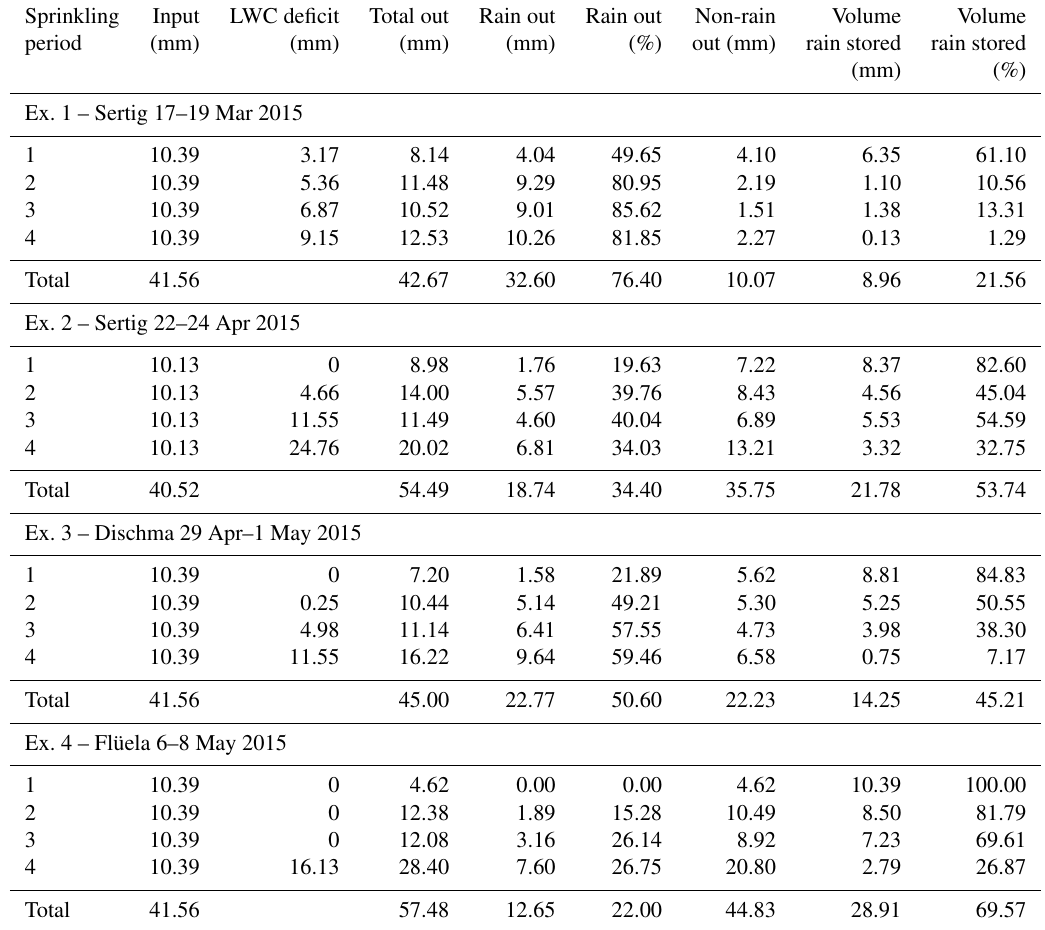
Table 6. Water balance computed for every outflow peak of the four sprinkling experiments. Sprinkling Input Volume